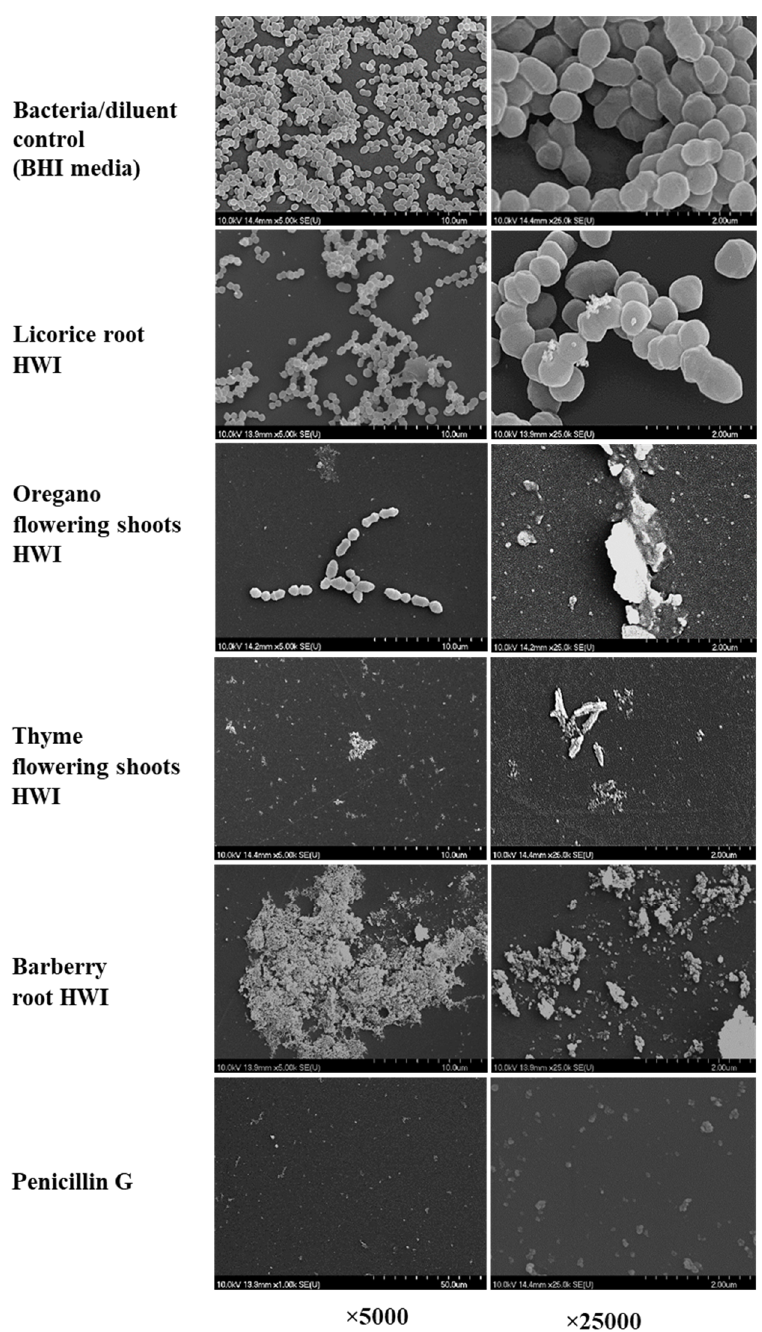
Figure 5. Scanning electron micrographs of biofilms of Streptococcus pyogenes formed on the microplate surface with the presence of hot water infusions of licorice roots, oregano flowering shoots, thyme flowering shoots, barberry root and penicillin G at their sub-inhibitory concentrations. HWI, hot water infusion.